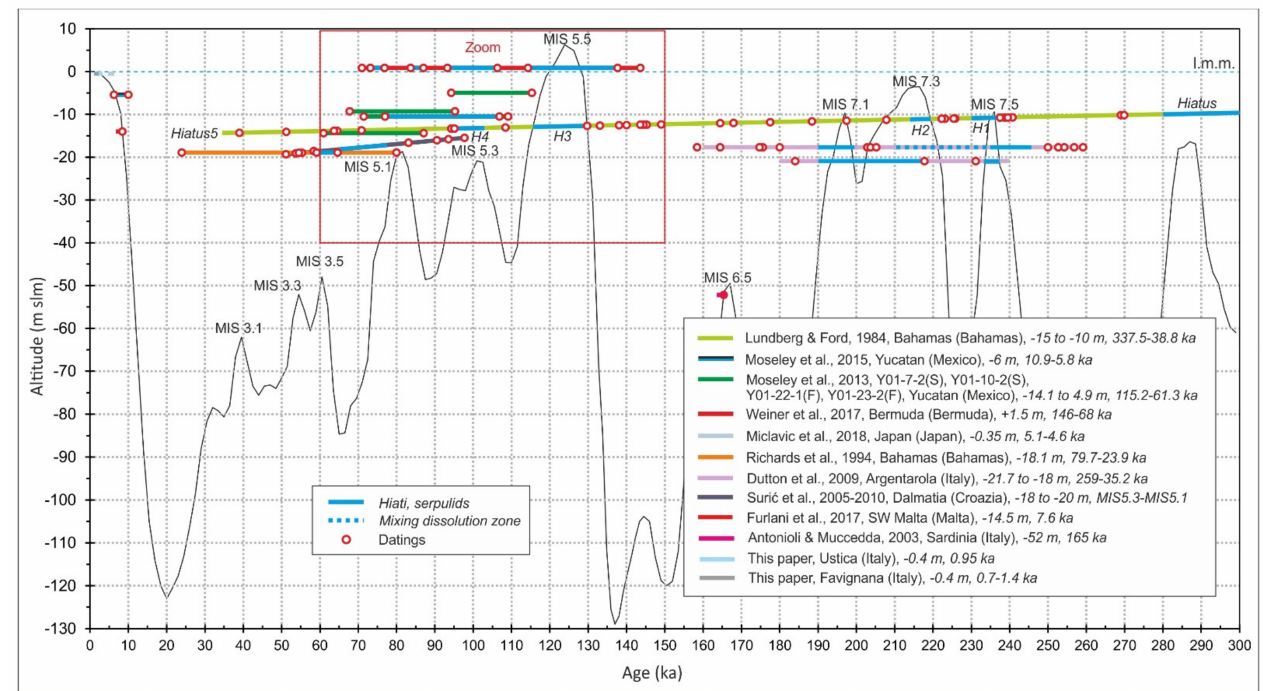
Figure 13. Elevations and radiometric ages (14C and U/Th) of the Caribbean, Japan, and some Mediterranean speleothems discussed in the present study and comparison with the: global sea level curve reconstructed by [79] Black line.